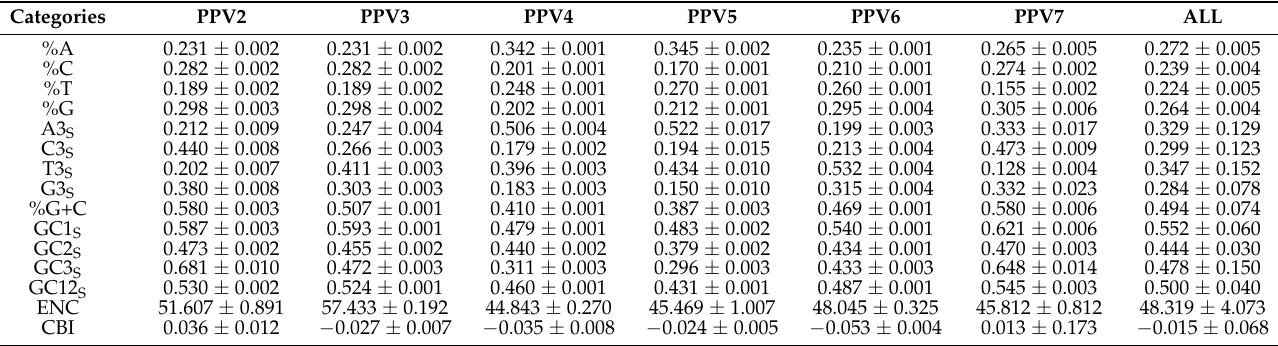
Table 1. Properties of structural protein genes from PPV strains analyzed in this study (mean value ± SD).